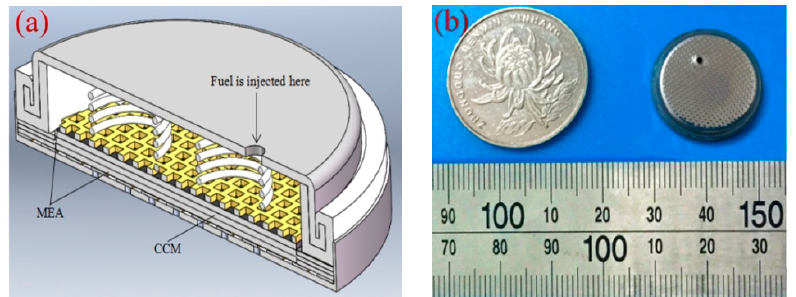
Figure 2. The layout of the 3DG + S B- μ DMFC.